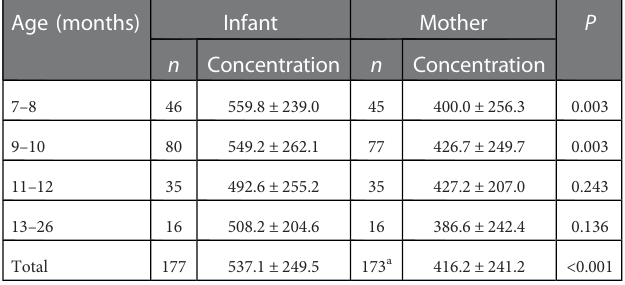
TABLE 2 Comparison of cytomegalovirus IgG levels (IU/ml) between the infants and mothers.